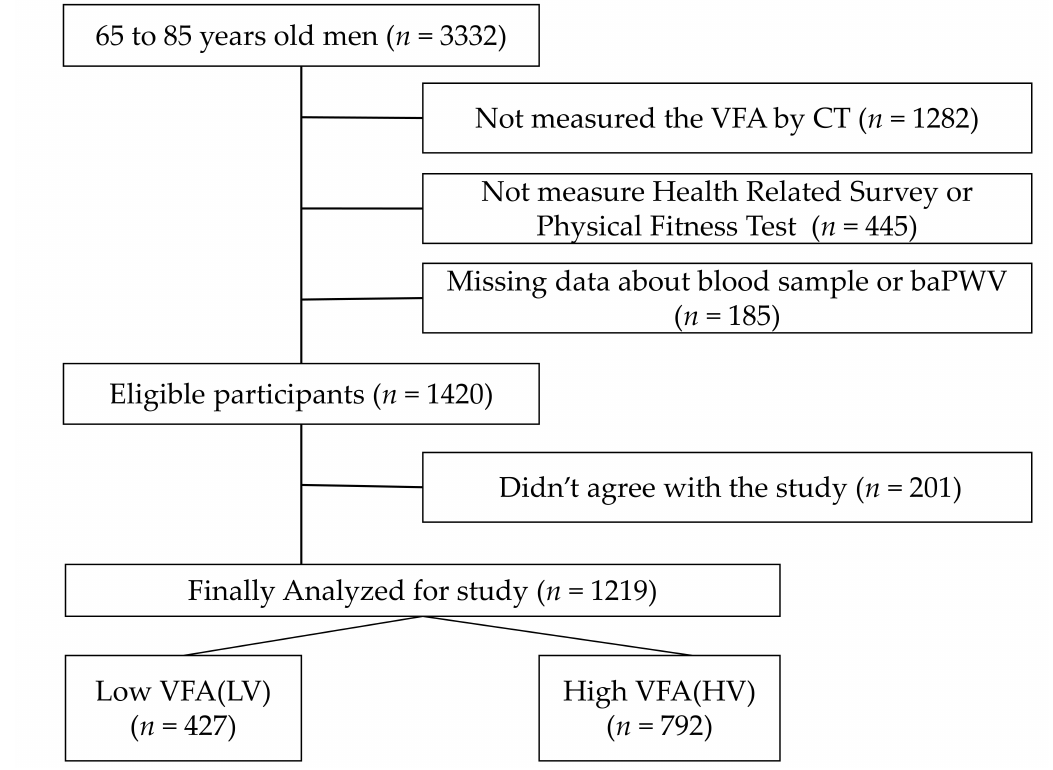
Fig. 1. Participant’s inclusion and exclusion criteria